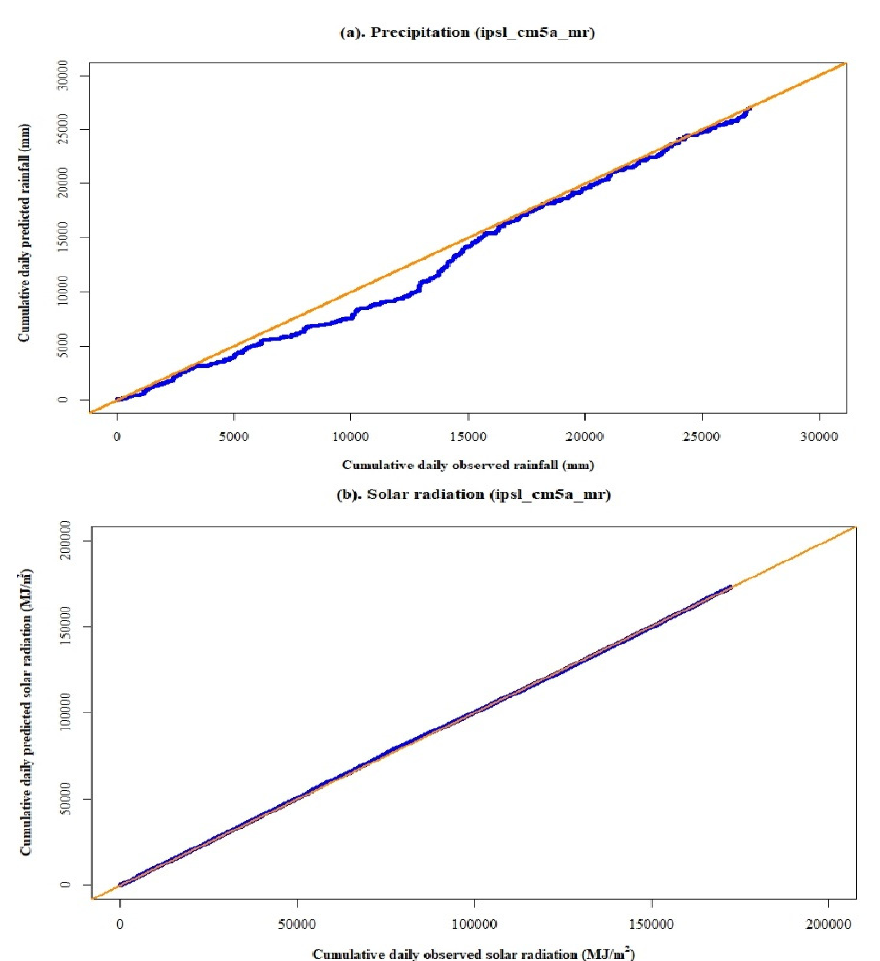
Figure 8. Double mass curve plots for the precipitation and solar radiation data by the model, ipsl_cm5a_mr, for the baseline period (1980–2004).